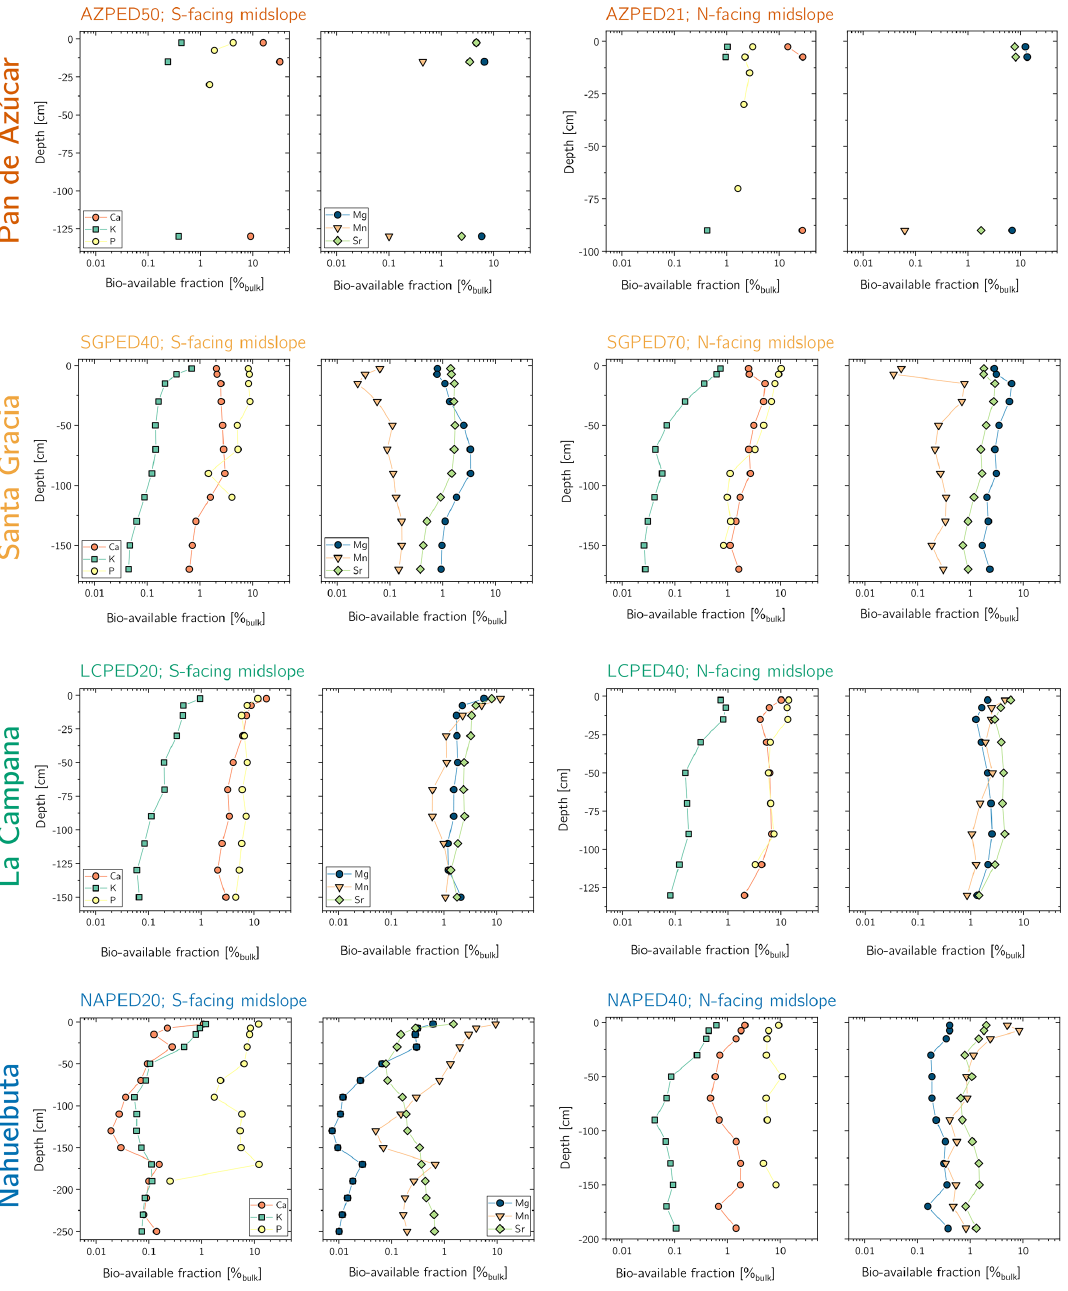
Figure A3. Depth distribution of the sequentially extracted bioavailable fraction of mineral nutrients including Sr, relative to their respective amount contained in bulk regolith, comprised of the water soluble (18M (cid:127) deionized H 2 O) and the exchangeable (1M NH 4 OAc) fractions. P accessibility in the bioavailable fraction has been determined by Brucker and Spohn (2019) using a modified Hedley sequential P fraction- ation method. Note that in Pan de Azùcar the acquisition of the bioavailable fraction was only possible on three samples per site. Data gaps do occur if both extractions of one sample were below the limit of